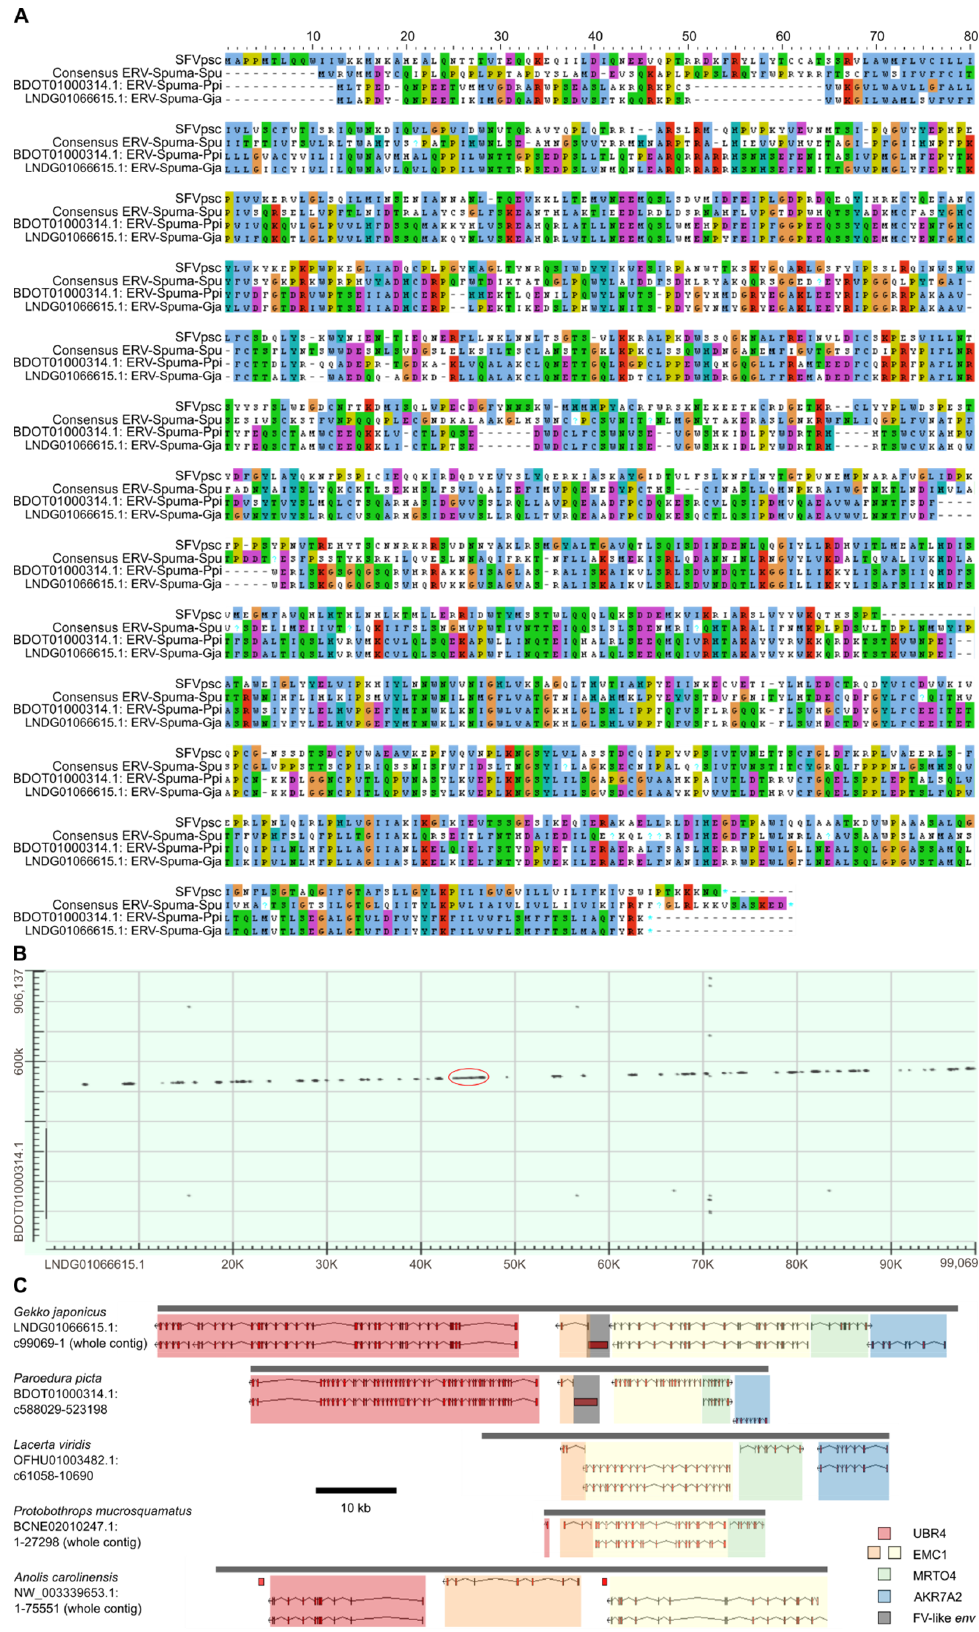
Figure 2. FV-like env sequences in panther gecko ( Paroedura picta , BDOT01000314.1) and Schlegel’s Japanese gecko ( Gekko japonicus , LNDG01066615.1). ( A ) Alignment of Env protein sequences of prototype FV (SFVpsc), consensus ERV-Spuma-Spu, and the two gecko FV-like endogenous viral